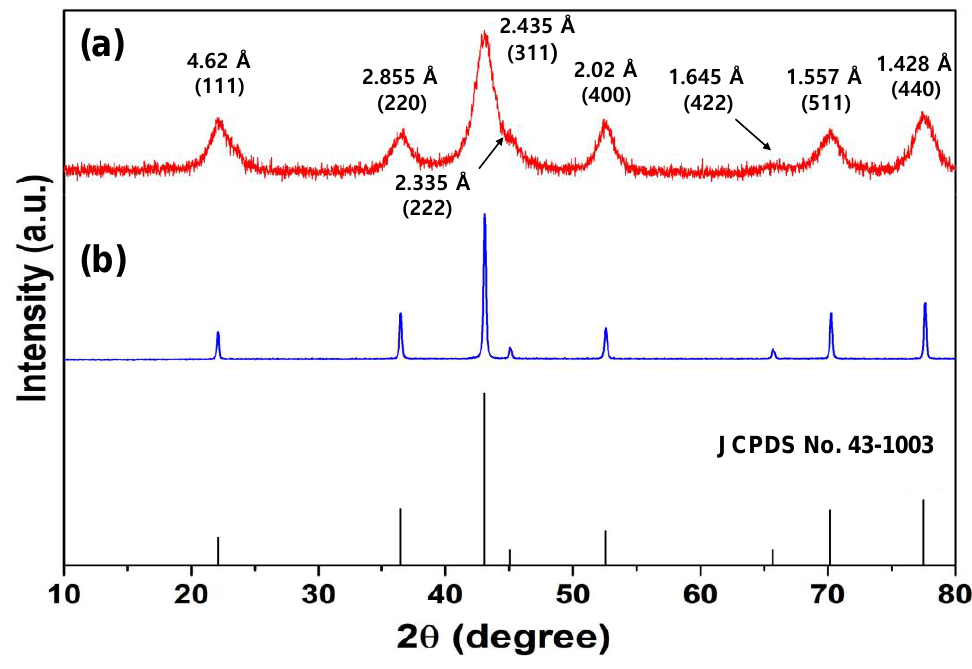
Figure 5. XRD patterns of ( a ) s -Co 3 O 4 after the alkali leaching process and ( b ) cm -Co 3 O 4 .